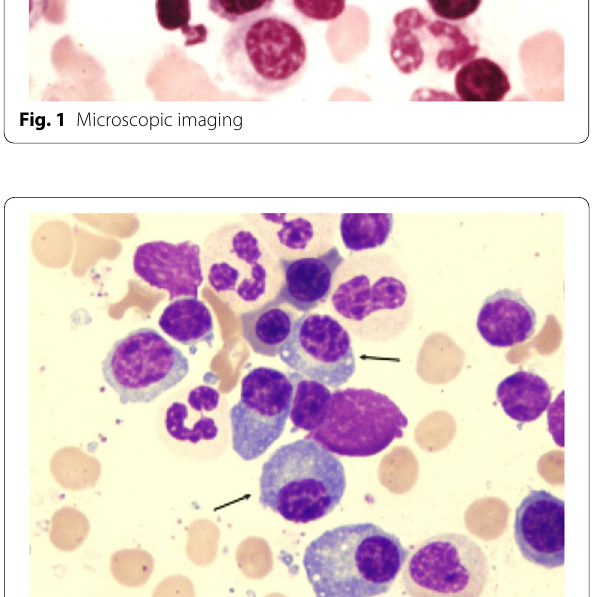
Fig. 2 Microscopic